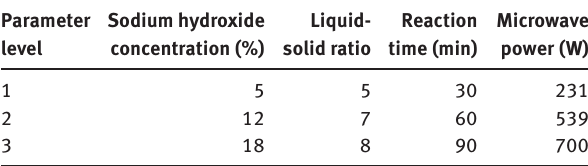
Table 1: Parameters and their levels in the leaching experiment.